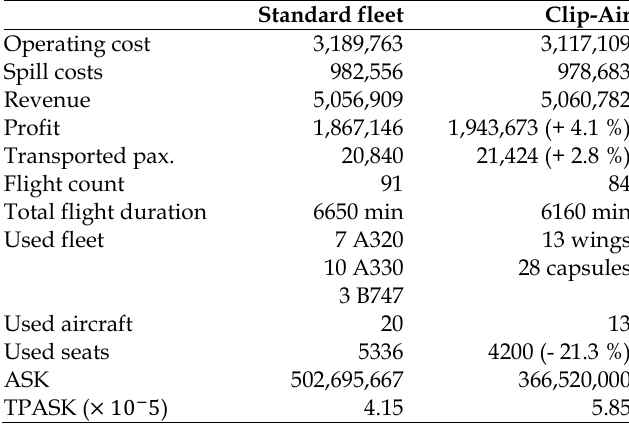
Table 9. Results for the peer-to-peer network Standard